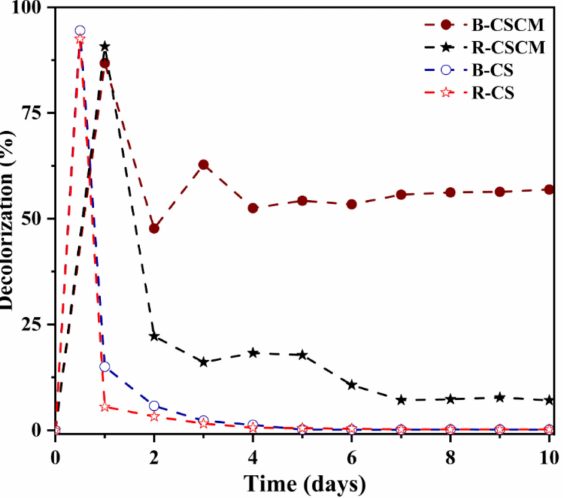
Figure 5. AO7 disappearance in CS and CSCM reactors; CS and CSCM